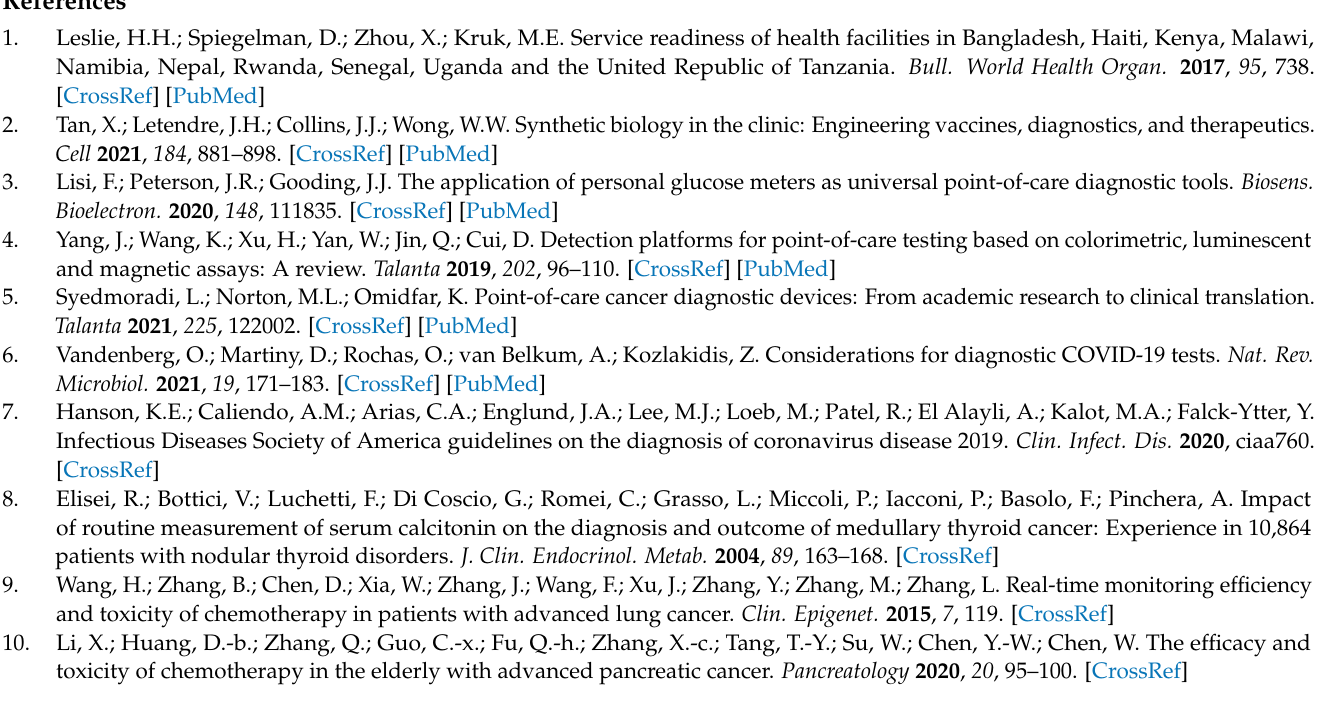
S5: Standard Deviation Equation; Figure S6: Glutamine sensor response plot including individual data points; and Table S1: Cost estimate for one replicate of a CFPS blood filtration test; and